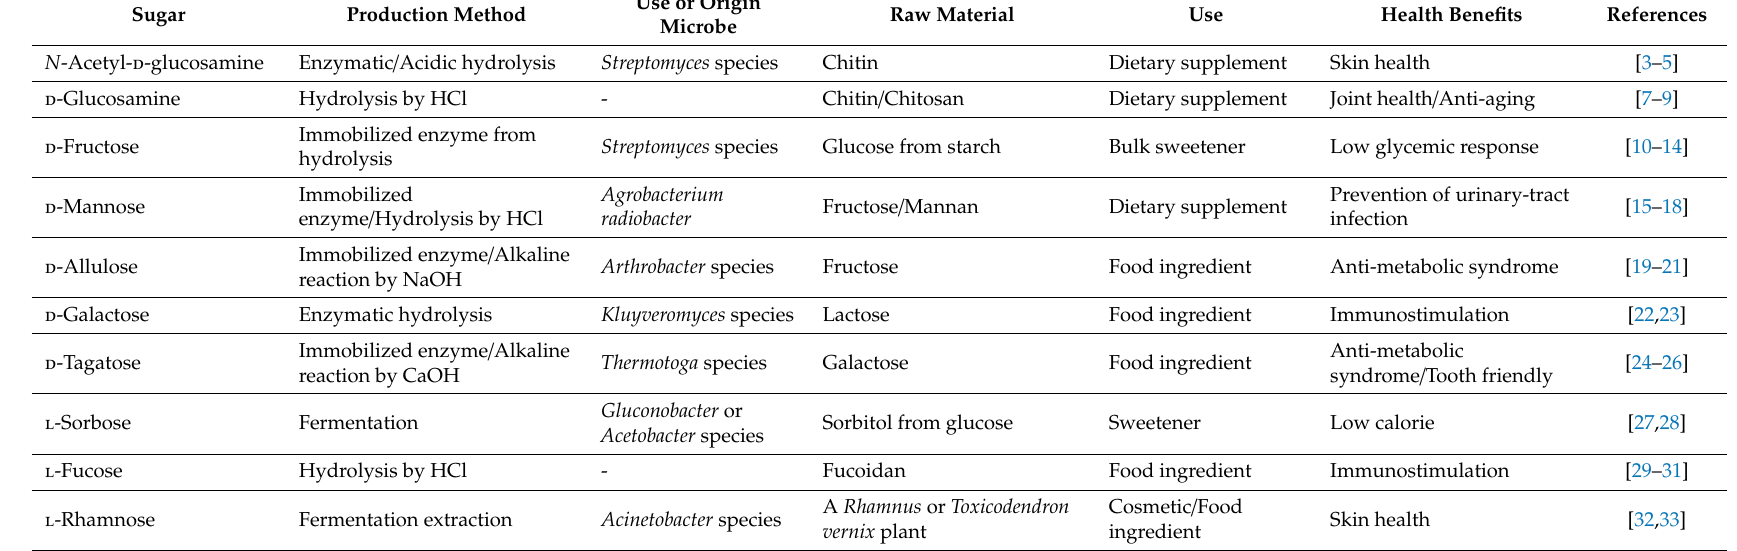
Table 1. Characteristics of hexose production and its